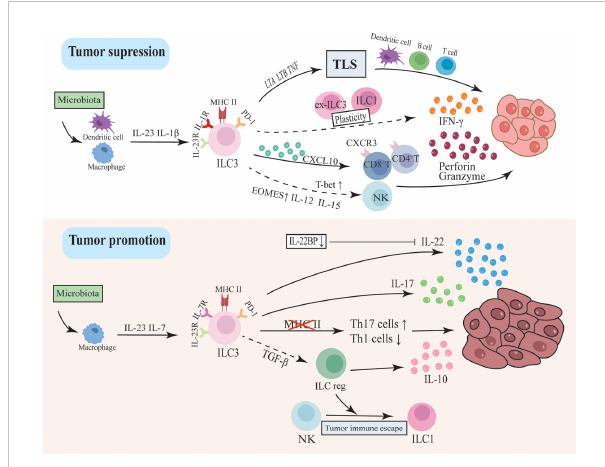
FIGURE 2 The dual function of ILC3 in intestinal tumorigenesis. ILC3s drive tumor development through in fl ammatory factors like IL-17 and IL- 22. This pathway may be regulated by intestinal fl ora activating macrophages to secrete IL-23 and IL-7. In addition, the loss of MHC II in ILC3 will lead to dysregulation between Th17 cells and type I immunity, thereby promoting tumor progression. ILC3 can also differentiate into ILCregs and secrete IL-10 to promote tumors. However, ILC3 may inhibit tumor progression by modulating the immune and microbial environment and supporting lymphoid tissue structure. ILC3 secretes CXCL10 and recruits CD4T and CD8T cells to in fi ltrate tumor cells and secrete IFN- g , granzyme and perforin to inhibit tumor cells. The plasticity of ILC3 between ILC1 and ex-ILC3 promotes IFN- g production. The recently discovered ability of ILC3 to differentiate into NK cells may also be an anti-tumor